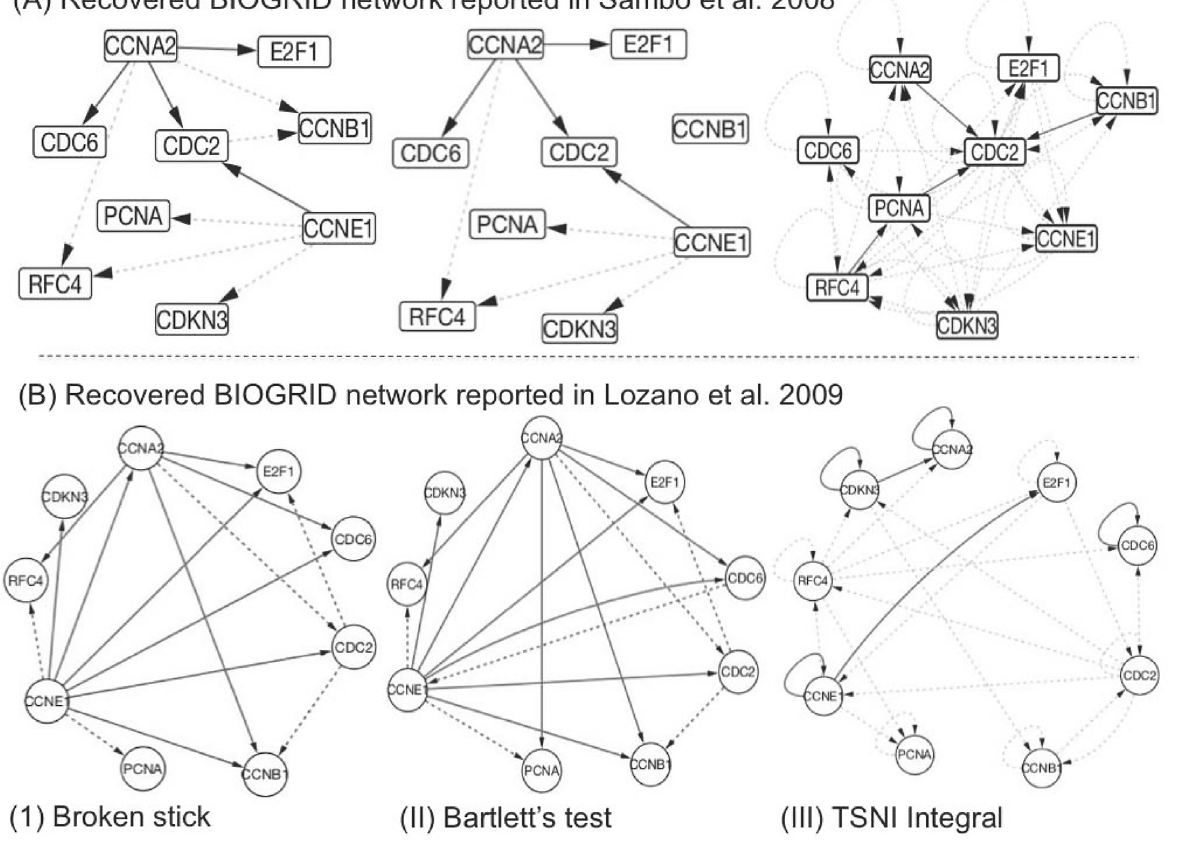
Fig 4. Reconstruction of human HeLa cell cycle network. Directed graphs recovered using (i) Broken stick (ii) Bartlett ’ s feature selection and (iii) TSNI integral methods applied to the BIOGRID reference network reported in Sambo et al. 2008 and Lozano et al. 2009 (A and B). Solid lines represent correctly inferred interactions (true positives) where as dash lines represent incorrectly inferred connections (False